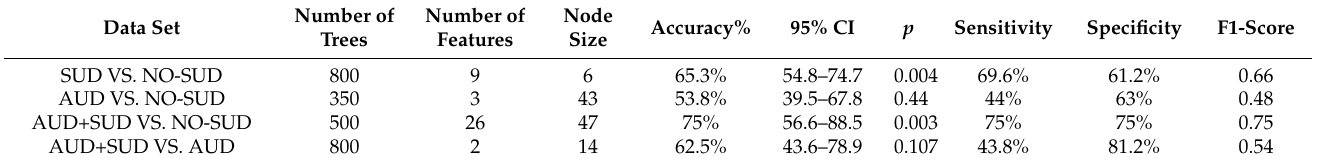
Table 2. Random forest model performance